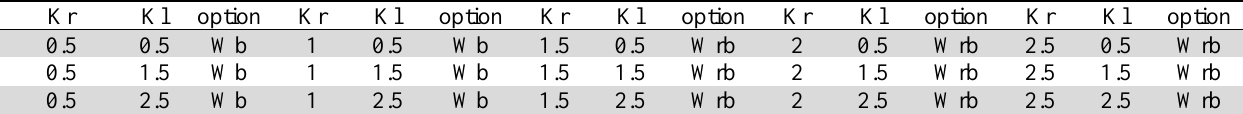
The results of different options